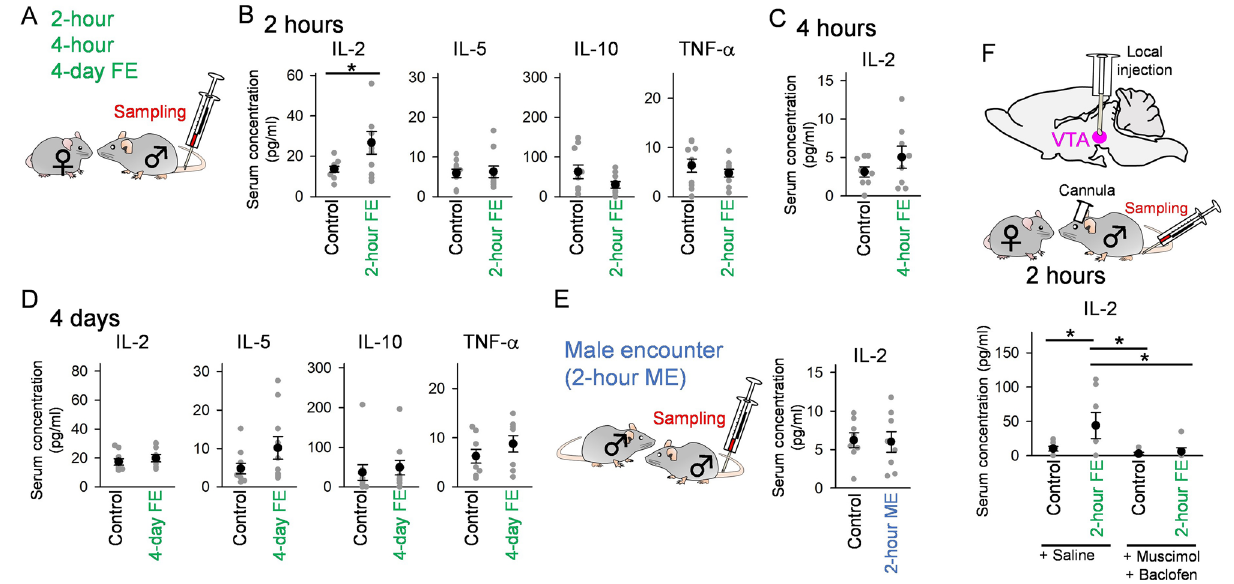
Figure 3. Female encounters increase serum cytokine levels, which are abolished by VTA inactivation. ( A ) A male mouse was subjected to a FE for 2 h, 4 h or 4 days, and a blood sample was collected. ( B ) Serum concentrations of four cytokines after a 2-h FE (Control, n = 10 mice; 2-h FE, n = 10 mice). Each thin dot represents one mouse. * P < 0.05. ( C ) Same as B but for a 4-h FE (Control, n = 8 mice; 4-h FE, n = 8 mice). ( D ) Same as B but for a 4-day FE ( n = 7–10 mice). ( E ) (Left) A male mouse freely interacted with the other male mouse for 2 h, termed a male encounter (ME), and blood sample was collected. (Right) Serum IL-2 concentrations after a 2-h ME (Control, n = 8 mice; ME, n = 8 mice). ( F ) (Top) To inhibit neuronal activity in the VTA, muscimol and baclofen were locally injected into the VTA of male mice subjected to a 2-h FE. (Bottom) Changes in serum IL-2 concentrations after inhibition of the VTA ( n = 6–7 mice). * P <